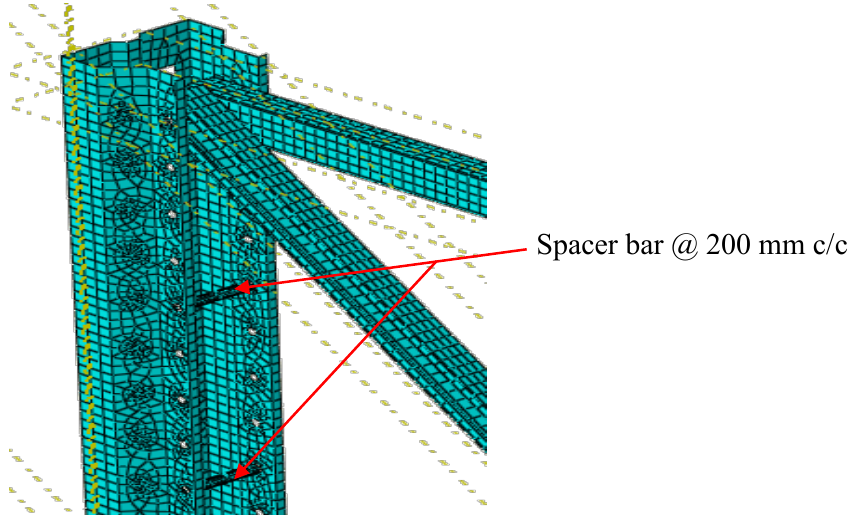
Fig. 9. Details of joint of frame and meshing of column section with spacer bar @ 200 mm c/c [12].